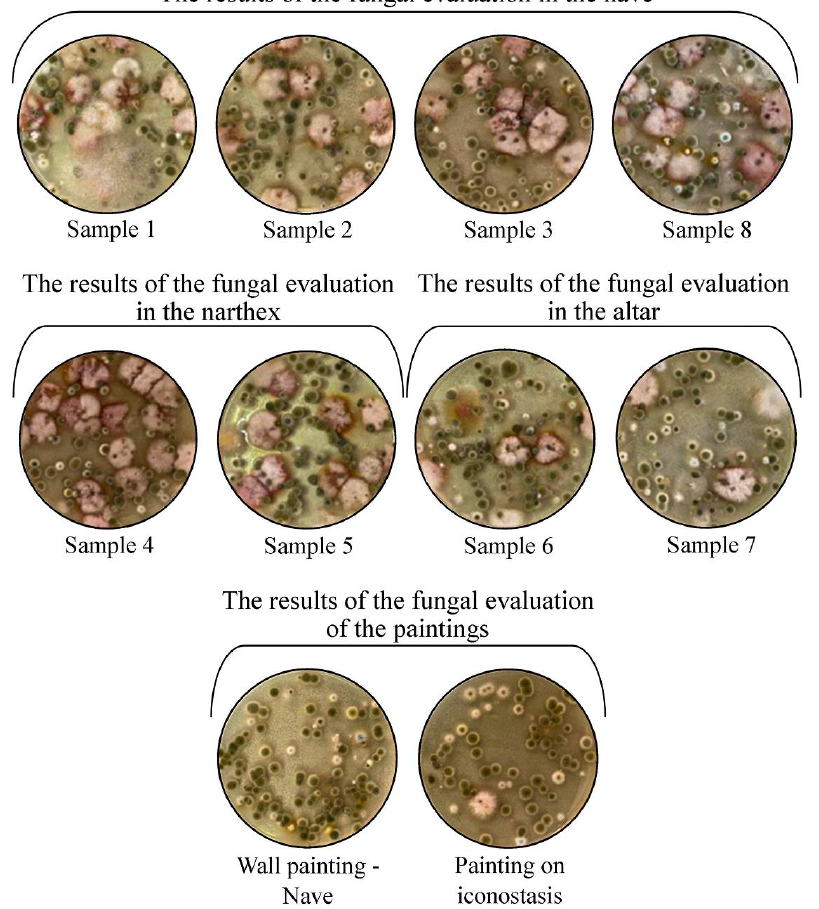
Figure 5. Appearance of fungal colonies at 72 h after sampling from the three rooms of the monument and from the inside paintings.